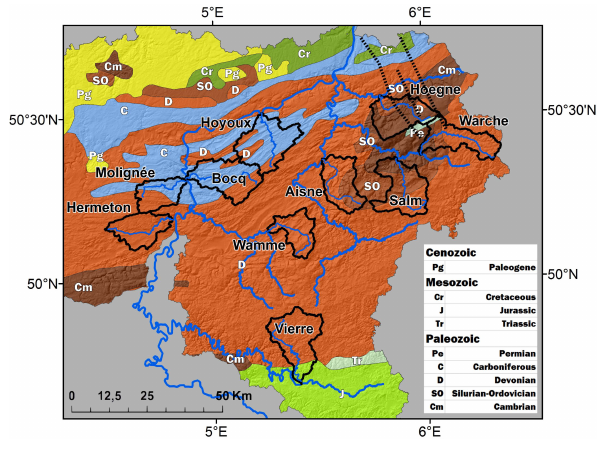
Fig. 2. Geologic map of the Ardennes Massif. The studied catch- ments are delimited in black, while the dotted lines on the NE rep- resent the location of an active fault system (Hocka ¨ ı Fault